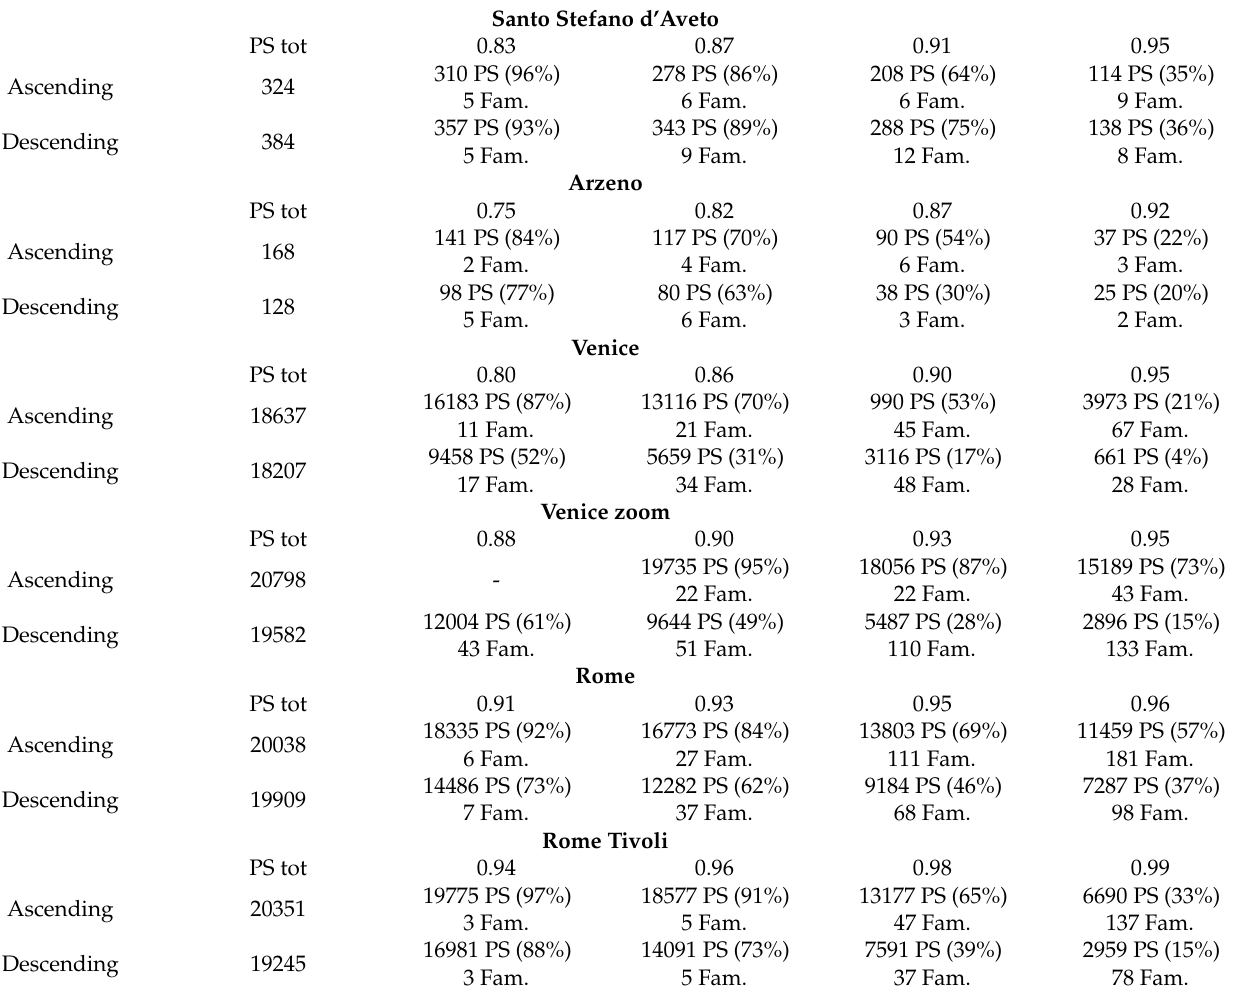
Table A1. Number of PS, percentage of remaining PS and number of families by varying the threshold are reported for each test